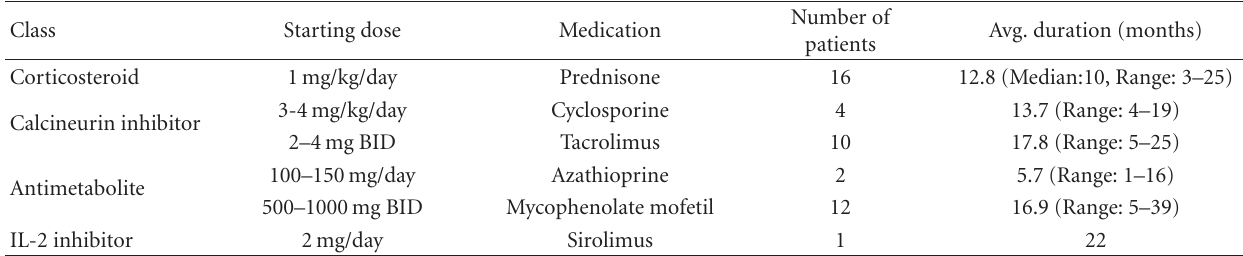
Table 1: Oral immunosuppression therapy